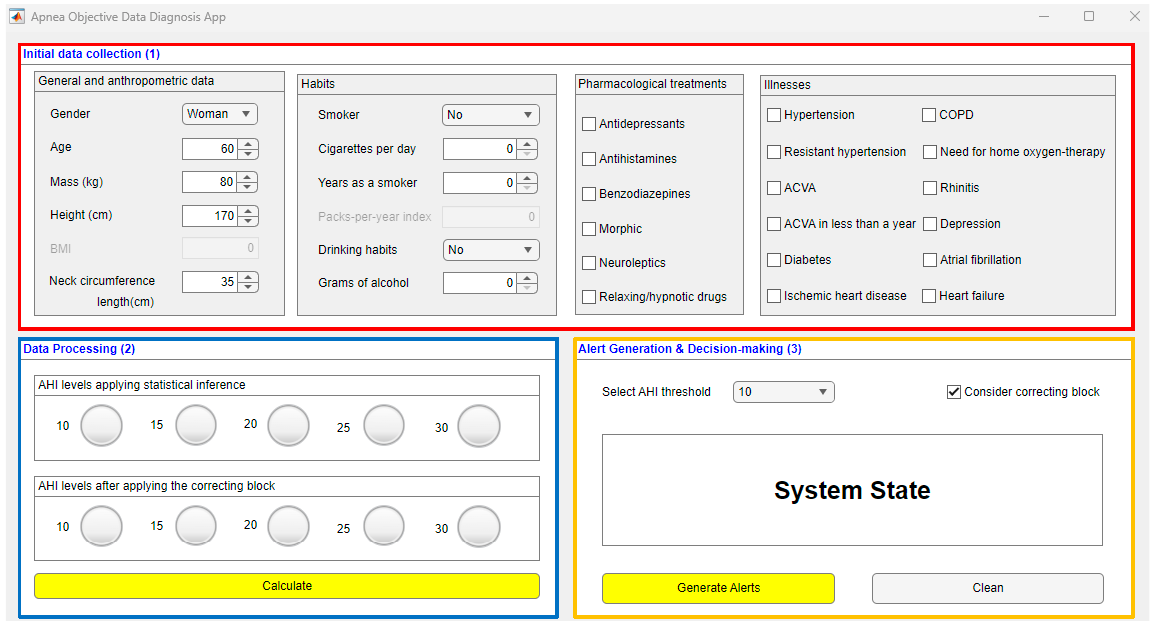
Figure 2. App screenshot. Region (1) refers to the stage of gathering and pre-processing the infor- mation of interest about the patient. Region (2) refers to data processing and visualization of AHI levels. Region (3) corresponds to the generation of alerts and decision-making.